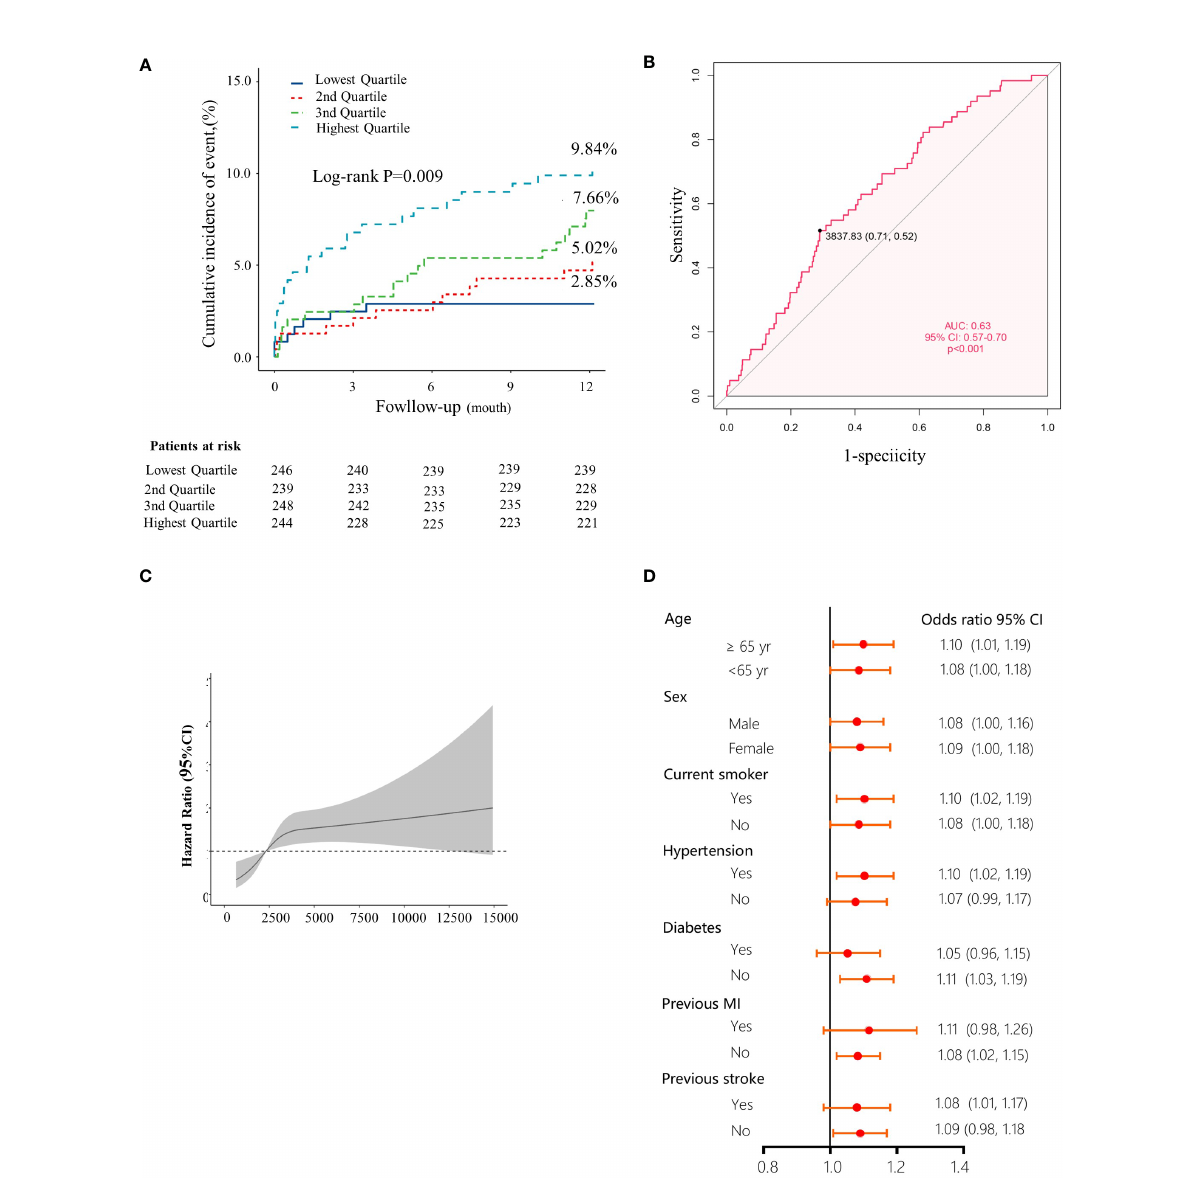
FIGURE 1 High levels of Kyn as a prognostic indicator in STEMI patients. (A) Kaplan-Meier plots indicated the association between quartile levels of Kyn and major adverse cardiovascular events, the numbers of STEMI patients in the different quartile groups were included in each graph. (B) Receiver operating characteristic curves for the patients with STEMI vs. control subjects for Kyn. (C) Restricted cubic spline modeling indicated the relationship between the plasma Kyn levels and the risk of MACCE. The solid line indicated the hazard ratios and the shaded areas, the 95% con fi dence intervals. (D) Forest plots showed that Kyn levels were associated with the prognosis in STEMI patients of subgroups according the STEMI prognostic analysis cohort data, after adjusting for per-standard deviation odds ratio (95% con fi dence interval) for the